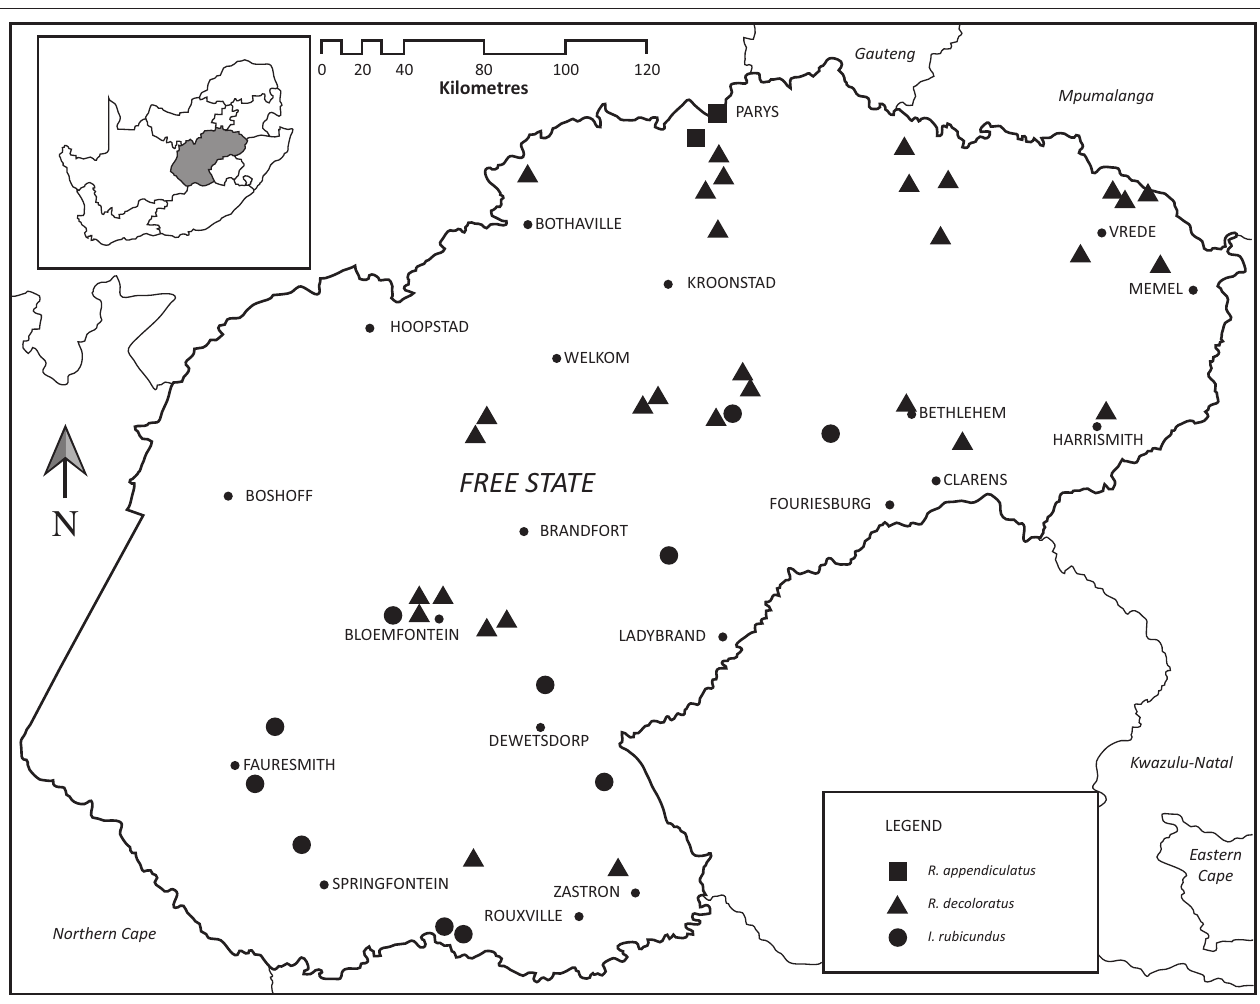
FIGURE 2: Localities at which the ticks Rhipicephalus appendiculatus , Rhipicephalus decoloratus and Ixodes rubicundus were collected in Free State Province, South